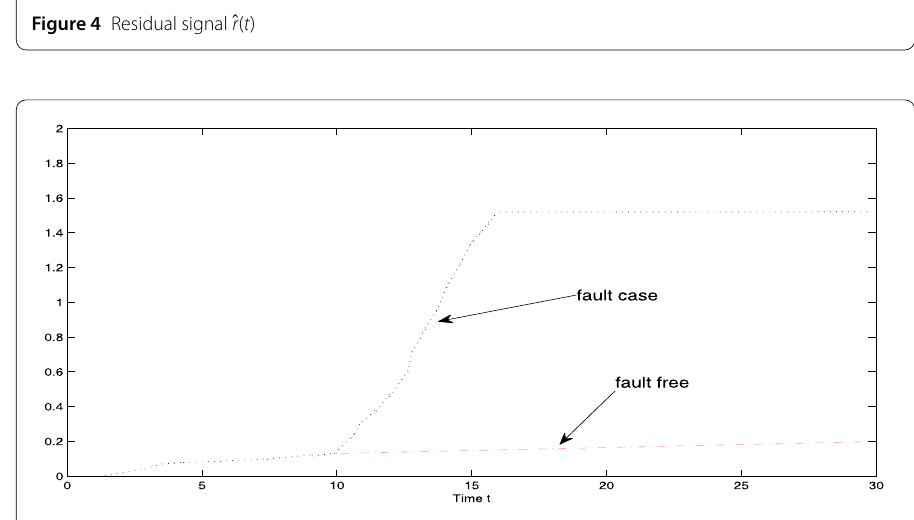
Figure 4 Residual signal ˆ r ( t )